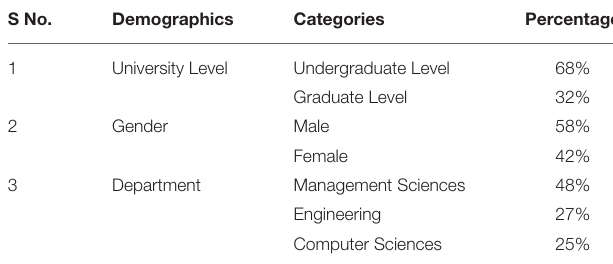
TABLE 1 | Demographics statistics.